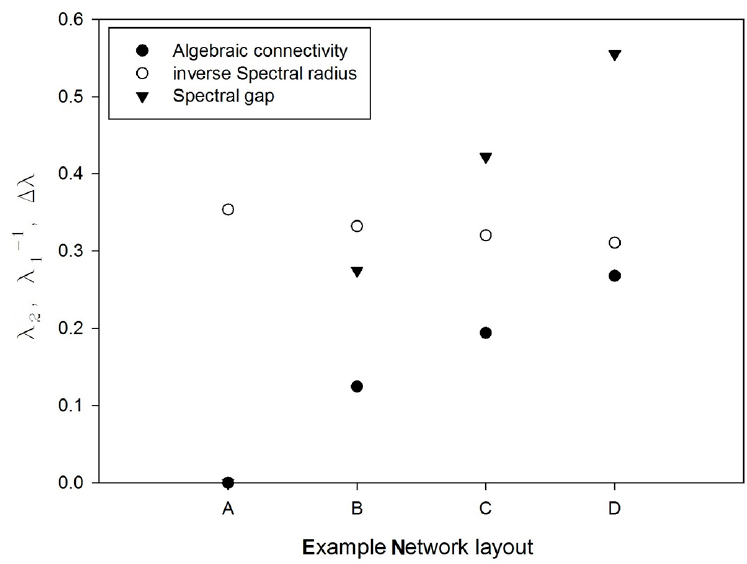
Figure 2. Algebraic connectivity, Inverse Spectral radius and Spectral radius for the layout A, B, C, and D of Example Network.